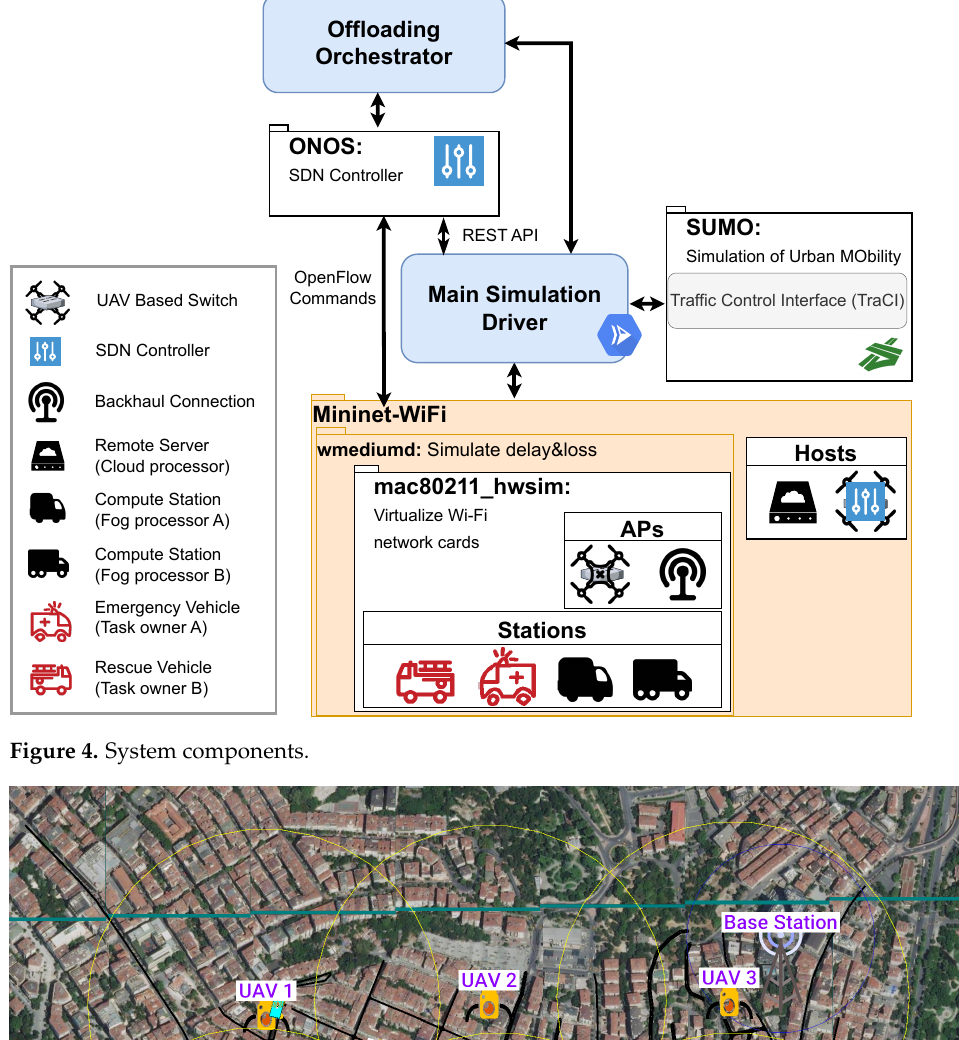
Figure 4. System components.